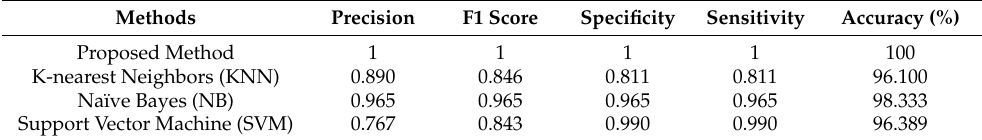
Table 5. Performance analysis of our proposed method by comparing with other